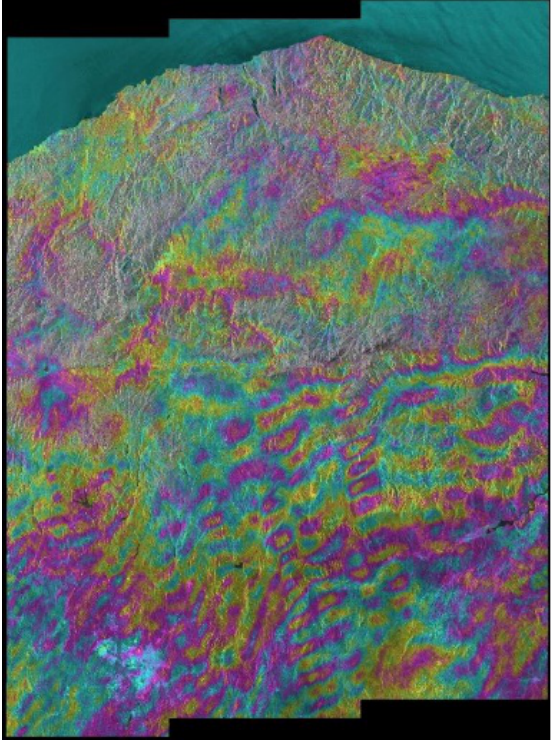
Figure 1. An interferogram processed using GAMMA on the CEMS/JASMIN system over Turkey. Using this facility allows COMET to undertake the large data processing requirements for the LiCS